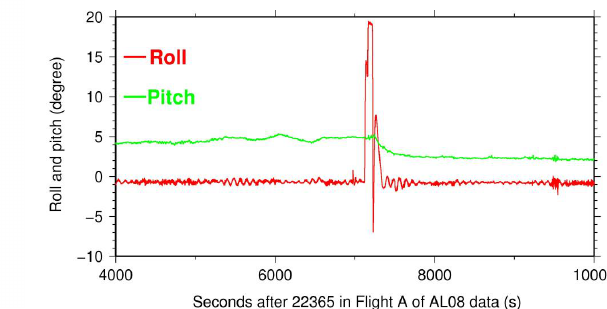
Figure 6. The IMU measured pitch angles along a typical flight.